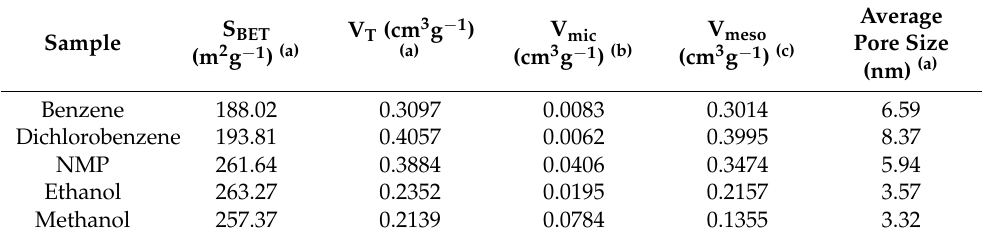
Table 1. Textural properties of carbon fibers grown by SPGS.